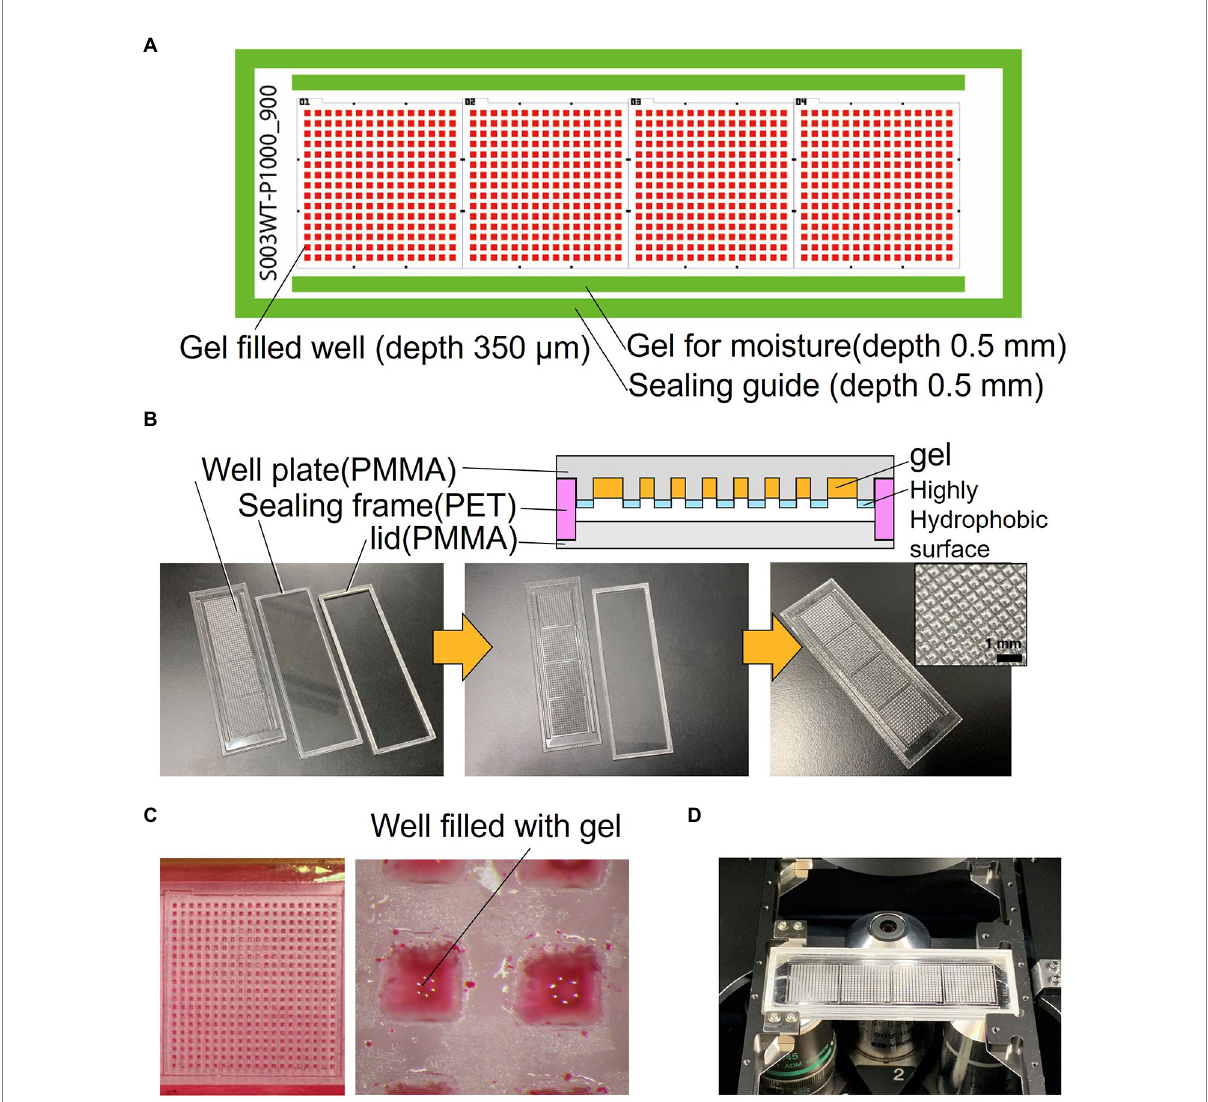
FIGURE 1 Structure of the resin-made gel-filled microwell array. (A) 2D arrangement of the device components. (B) Cross sectional view and photograph of the device. (C) Micrograph of gel-filled wells. (D) Photograph of the device mounted on